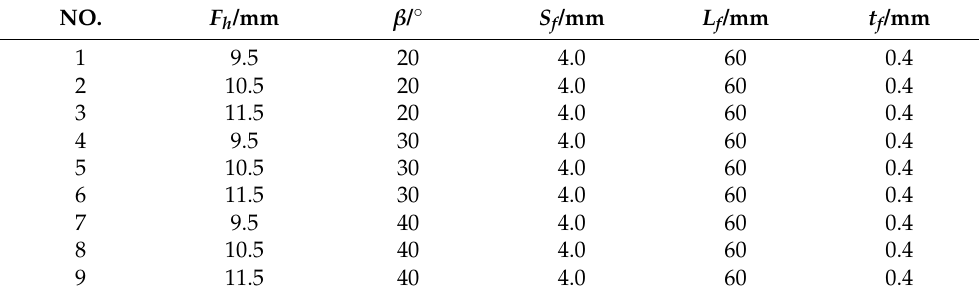
Table 2. Parameter table for trapezoidal flow channels.